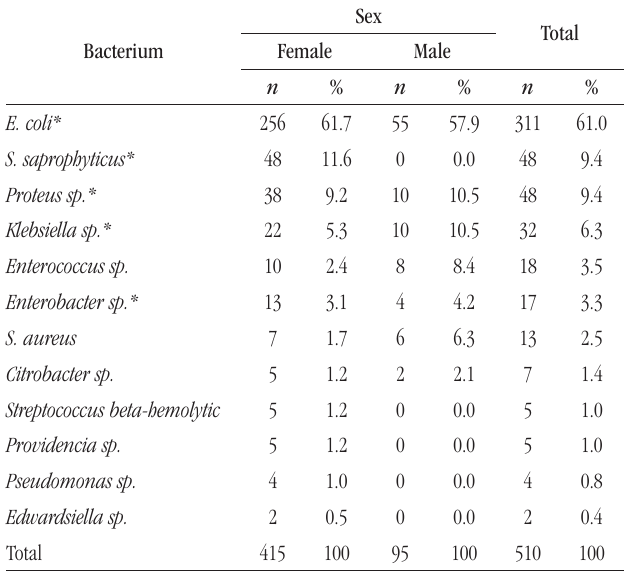
tABLE 3 – Resistance profile of major uropathogens isolated in outpatients samples in Jataí, from March 2010 to June